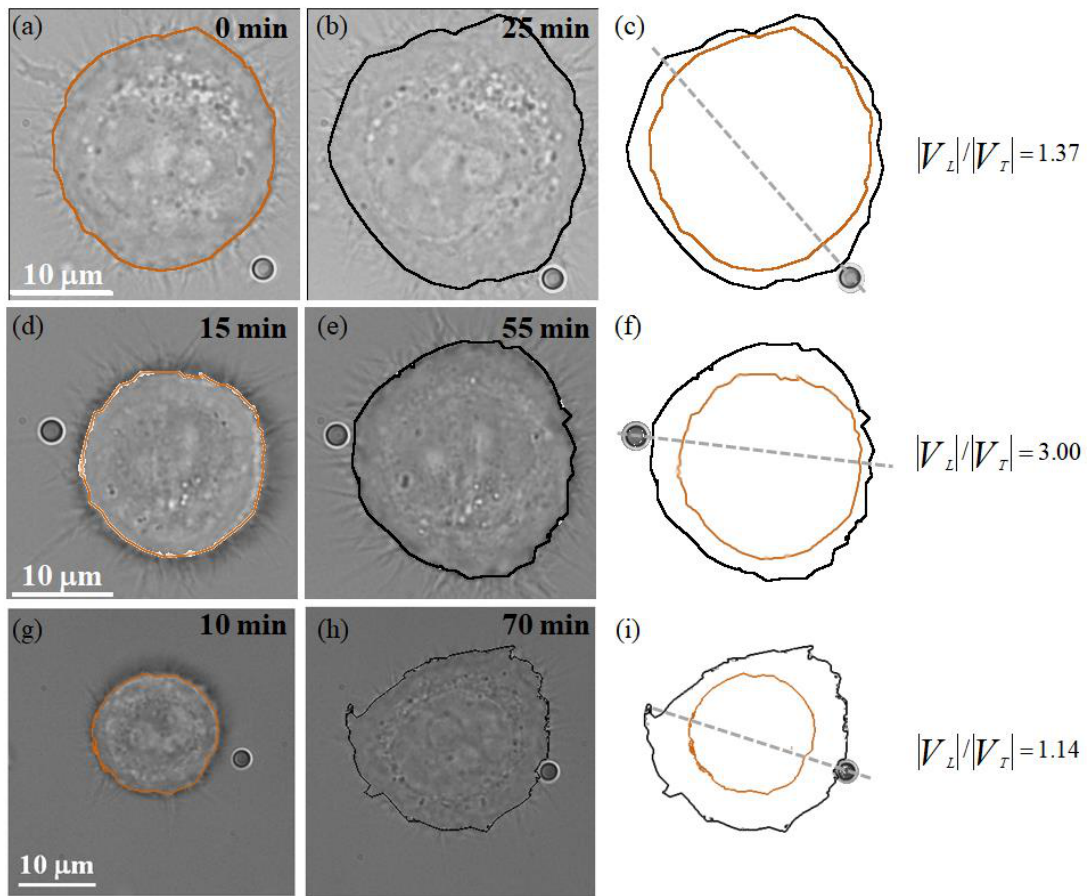
Figure 4. Consecutive bright-field images of individual cellular responses during stuck EGF-coated-bead stimulation, where the stuck EGF-coated bead was intended to contact the filopodial actin filament of the HT29 cell. ( a , b , d , e , g , h ) The HT29 cells at the t 0 and t 1 time points, respectively. ( c , f , i ) The corresponding 2D cell body contours and the value of | ⃑⃑⃑ |/|𝑉 ⃑⃑⃑⃑ | during stuck EGF-coated-bead stimulation.